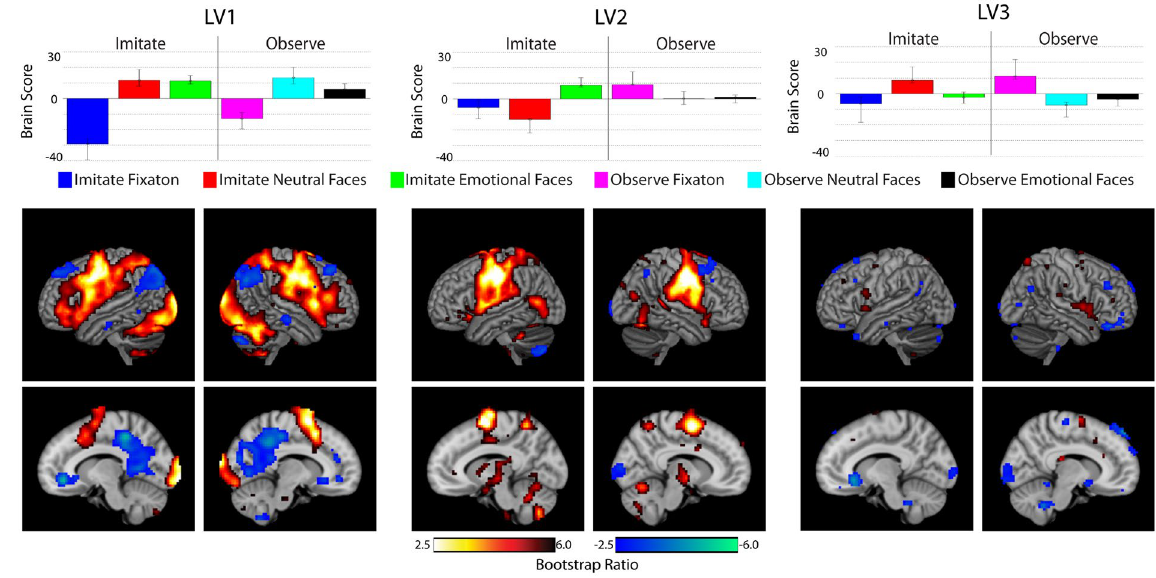
Figure 1. Results from the first latent variable using task PLS analysis. Data is shown for LV1, 2 and 3. The top panel shows the design pattern (the contribution of each condition to the LV). Error bars are 95% confidence interval derived from the bootstrap analysis. The bottom panel shows the voxel pattern from the first lag of the PLS analysis rendered on the cortex. Sagittal slices are shown for X = − 10 (left) and X = 10 (right). Voxel intensity is displayed as bootstrap ratio, a measure of reliability of voxels within the LV. Red-yellow regions show the pattern described by the design pattern, while blue regions show the opposite